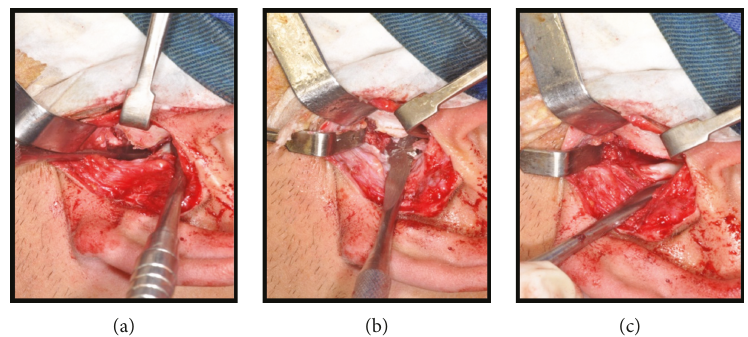
Figure 8: (a), (b), and (c) Transoperative pictures emphasizing the eminectomy on the left side.